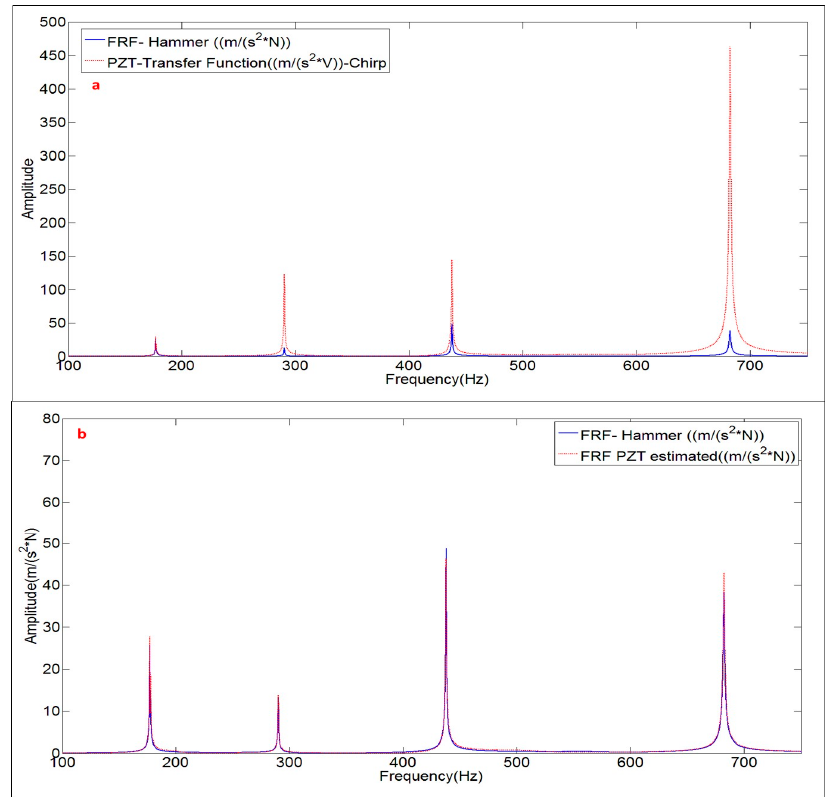
Figure 15. ( a ) Comparison PZT transfer function with FRF; and ( b ) comparison FRF estimated with the PZT and FRF obtained with the Hammer. Structure with infinite water medium.